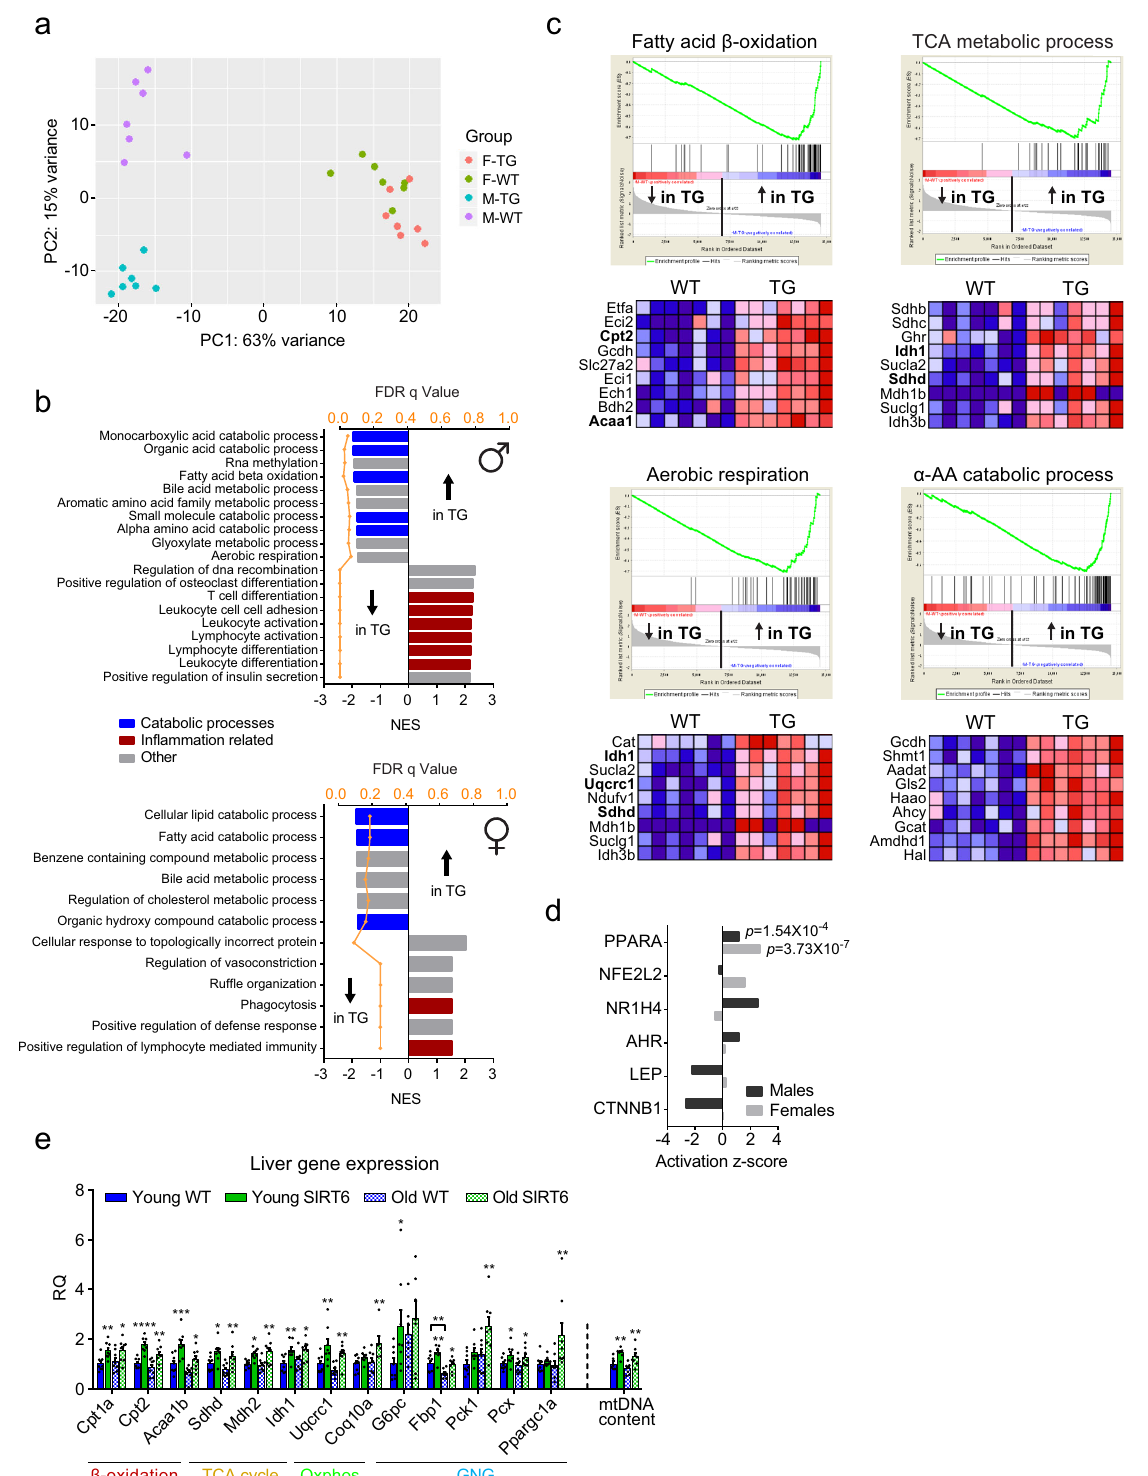
male mice utilized for RNA-seq was performed. Liquid chromatography-tandem mass spectrometry (LC-MS/MS) analy- sis identi fi ed and quanti fi ed 2785 hepatic proteins. PCA of the proteomics data revealed that groups were clustered by genotype (Supplementary Fig. 5a). The global transcriptome correlated well with the proteome ( r = 0.59, p < 0.0001; Supplementary Fig. 5b). From the total expression list, 185 proteins were differentially expressed between genotypes (Benjamini-Hochberg corrected p <